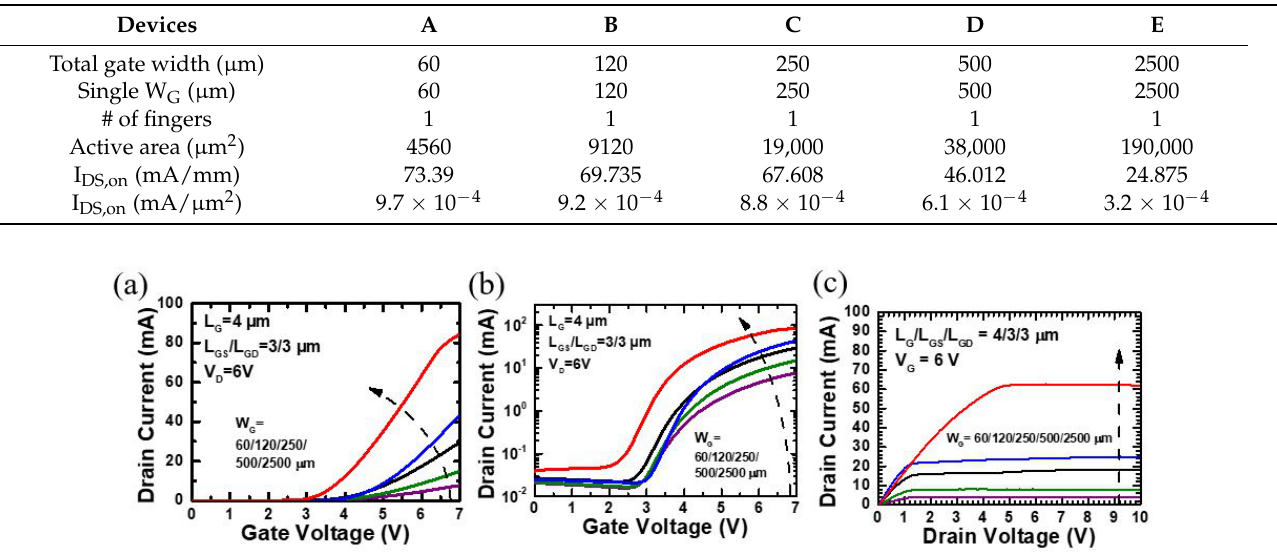
Table 1. Design parameters for single finger devices with different gate widths (W G ).